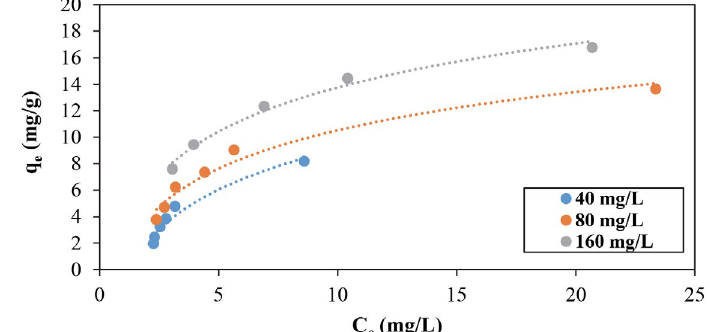
Fig. 10. Adsorption isotherm of Acid Violet 17 at different adsorbent